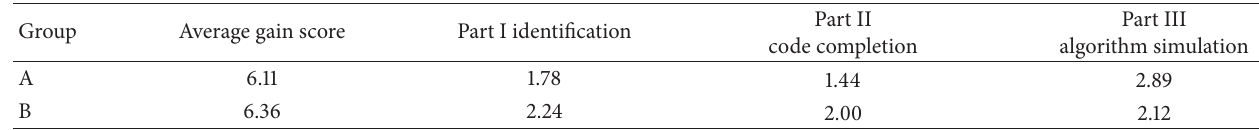
Table 2: Average gain scores of groups A and B.